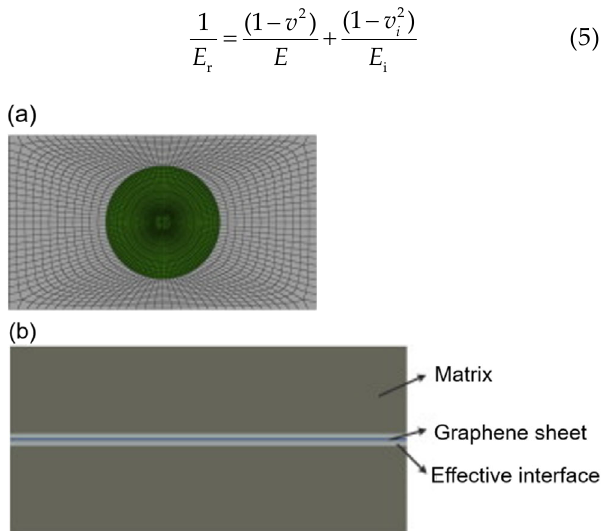
Fig. 4 (a, b) 3D computational model of the effective interface properties between a graphene sheet and polymer matrix. Reproduced with permission from Ref. [63], © Elsevier B.V.